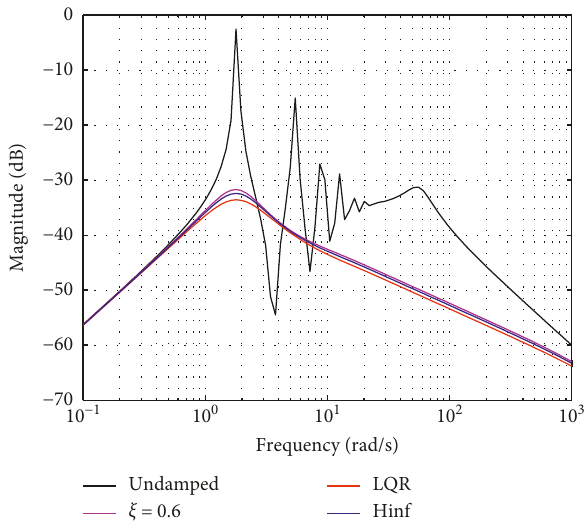
Figure 11: Dominant poles for LQ controller design—maximum stability margin.